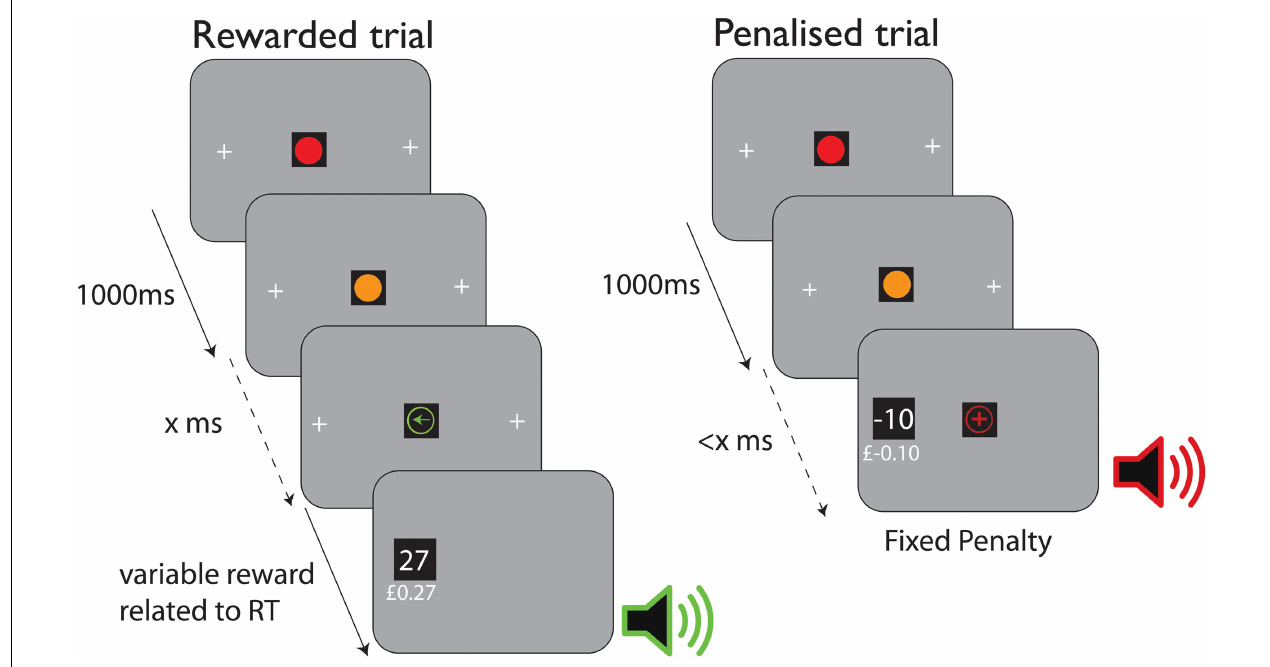
made in relation to the onset of green (RT ms). Responses made subsequent to the onset of green onset are rewarded (left stream) whereas responses made prior to the onset of the green light are penalized (right